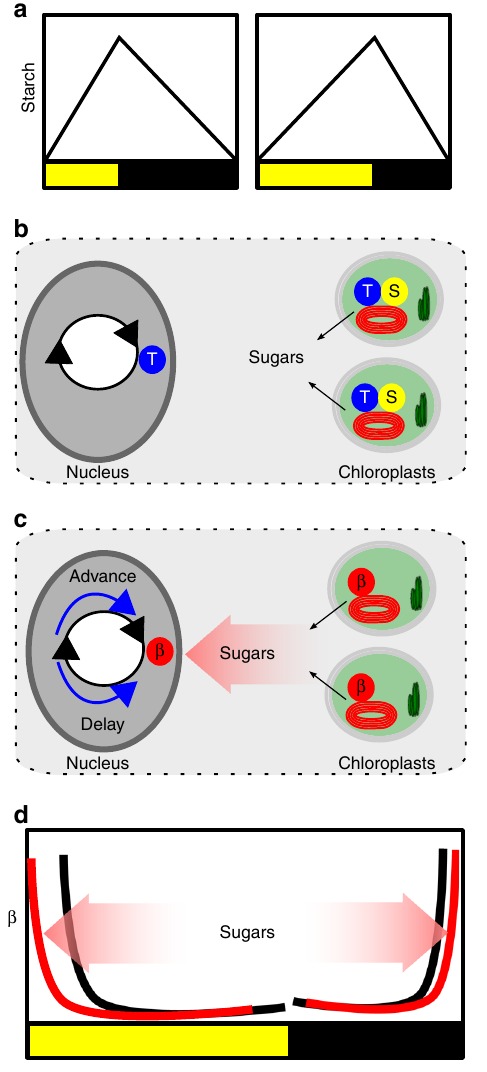
Fig. 5 Dynamic plasticity of circadian rhythms might contribute to carbon homoeostasis in Arabidopsis. a There are diel changes in the transient starch pool stored in the chloroplasts, with the rate of accumulation and loss being near linear and adjusting to the photoperiod. b It has been proposed that the circadian clock generates an output that is a measure of time until dawn (T). This interacts with a measure of the size of the starch granule (S) to set a constant rate of starch degradation until dawn. In this model, the rate of degradation is calculated individually in the 100s of chloroplasts in a mesophyll cell. This model class assumes that starch pool size is regulated 63 . c Another proposal is that the circadian clock regulates the starch degradation activity ( β ), such that it peaks near dawn. Sugars released from starch degradation in the chloroplast feedback to regulate the circadian oscillator in the nucleus by affecting the pool of available C. The circadian oscillator is dynamically adjusted to maintain available C homoeostasis in a form of retrograde signalling 58 . d In the morning, a rising rate of change of sugars promotes phase advance (red), which will have the effect of reducing β at any particular time point. A phase delay in the morning will increase β at any time point, increasing starch degrading activity (not shown). Phase delays by sugars at night will have the effect of reducing